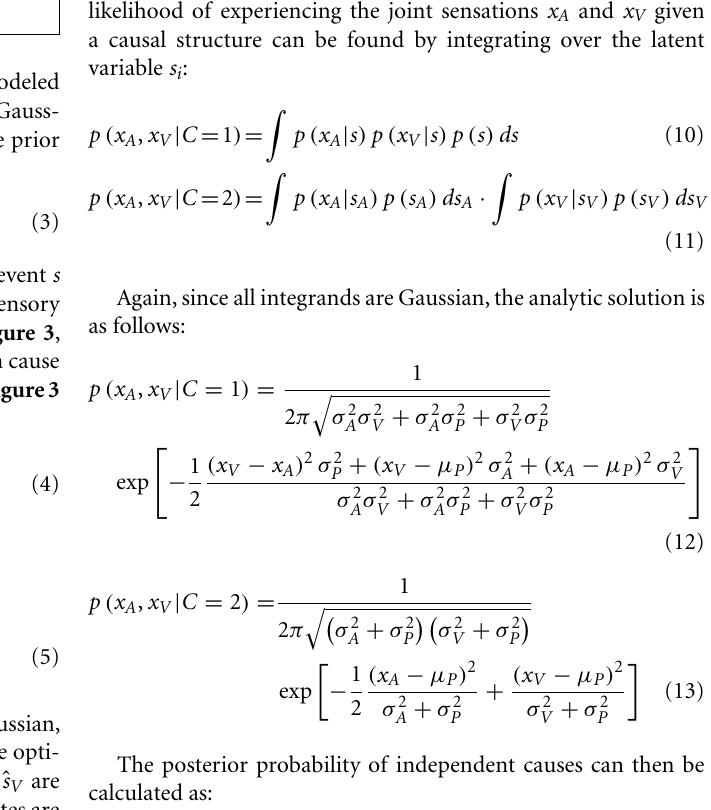
FIGURE 3 |The causal inference model. Left: One cause can be responsible for both visual and auditory signals, x V and x A . Right: Alternatively, two independent causes may generate the visual and auditory sensations.The causal inference model infers the probability of a common cause (left, C = 1) vs. two independent causes (right, C = 2).The latent variable C determines which model generates the